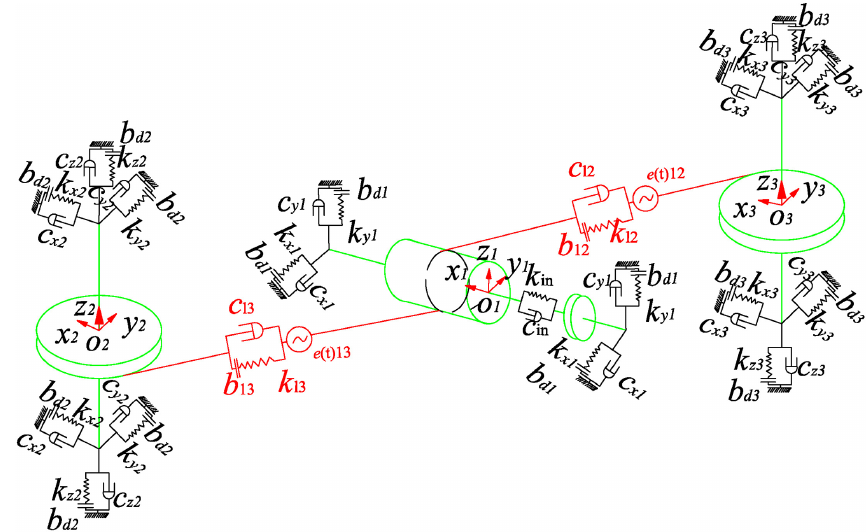
Figure 3. Dynamic model of the one-stage face gear.